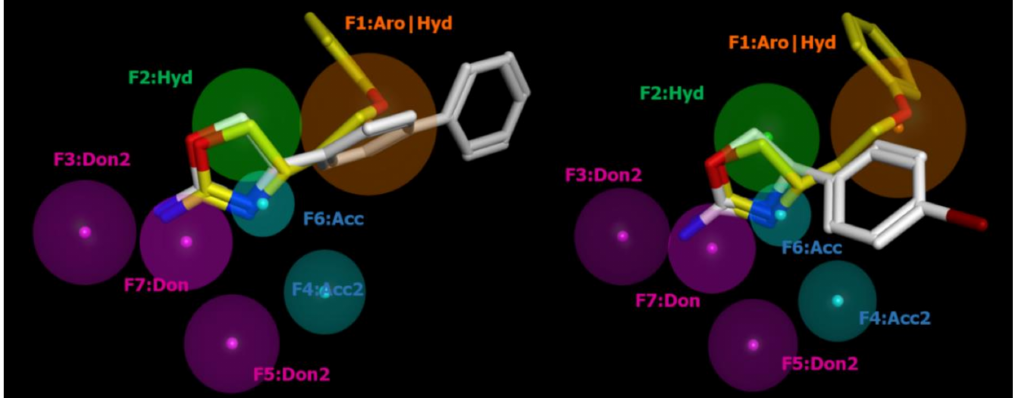
Figure 6. Pharmacophore features shared by most of the oxazolines acting as h TAAR1 agonists. The most potent derivative, 20b , is depicted by bold sticks (colored as in Figure 4). The less potent analogues, 30b ( left ) and 27b ( right ), are also shown for comparison ( C atoms colored in white).